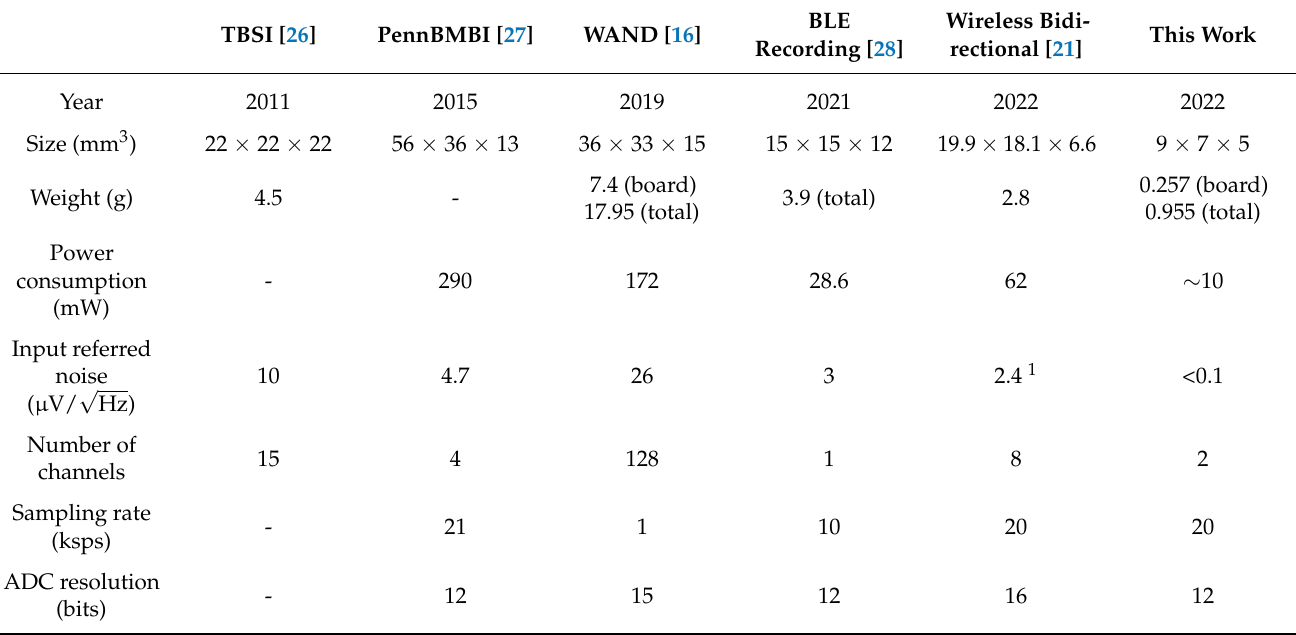
Table 1. Comparison of the microsystem features and other wireless recording systems fully validated in